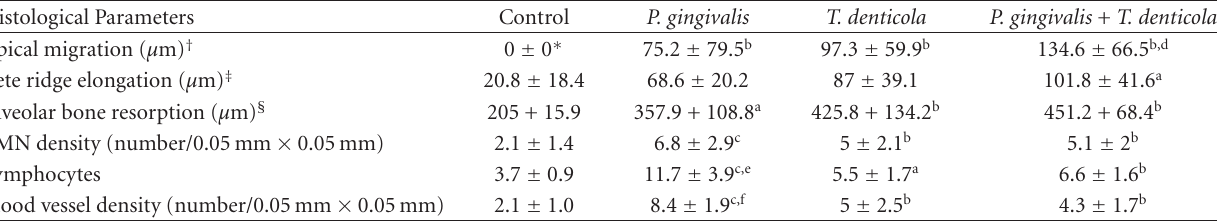
Figure 3: Interproximal evaluation of alveolar bone loss. Radiographic vertical alveolar bone resorption (12 weeks of periodontal disease) in rats ( n = 6) following mono infection with P. gingivalis or T. denticola and with the mixed infection . Each bar indicates the mean interproximal alveolar bone loss for distance measured between CEJ and ABC at mesial and distal sites of three molar teeth (6 sites). The error bars indicate standard deviation from the mean. An asterisk sign denotes significantly di ff erent from sham-infected control rats ( P < . 05). The # sign indicates significant di ff erence comparing between mono bacterial P. gingivalis and the mixed microbial infected rats ( P < . 05) and & sign indicates significant di ff erence comparing between T. denticola and the mixed microbial infected rats ( P < . 05). Pg , P. gingivalis ; Td , T. denticola ; Cont; sham-infected control. Table 2: Histometrical analysis of rat periodontal tissue after primary infection with P. gingivalis and T. denticola as mono- and mixed